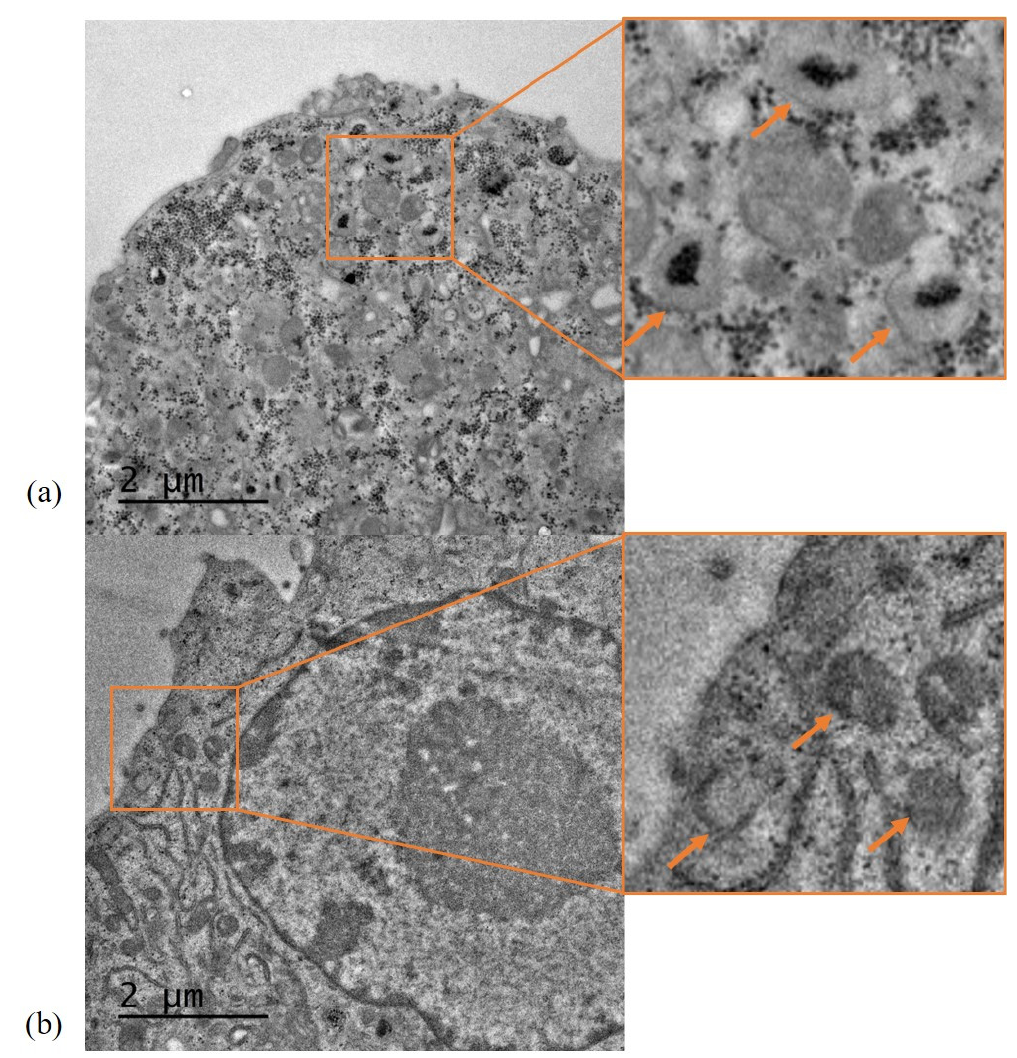
Figure 6. TEM micrographs of SLN-A nanoparticle uptake by DC2.4 cells. ( a ) Cells treated with SLN-A nanoparticles; ( b ) Control cells without nanoparticle treatment. Nanoparticle uptake was evident within cells treated with SLN-A nanoparticles (image a), with aggregation in endosomes (inset). No nanoparticle uptake was seen in the control cell sample (image b), where empty endosomes were observed (inset). Scale bar 2